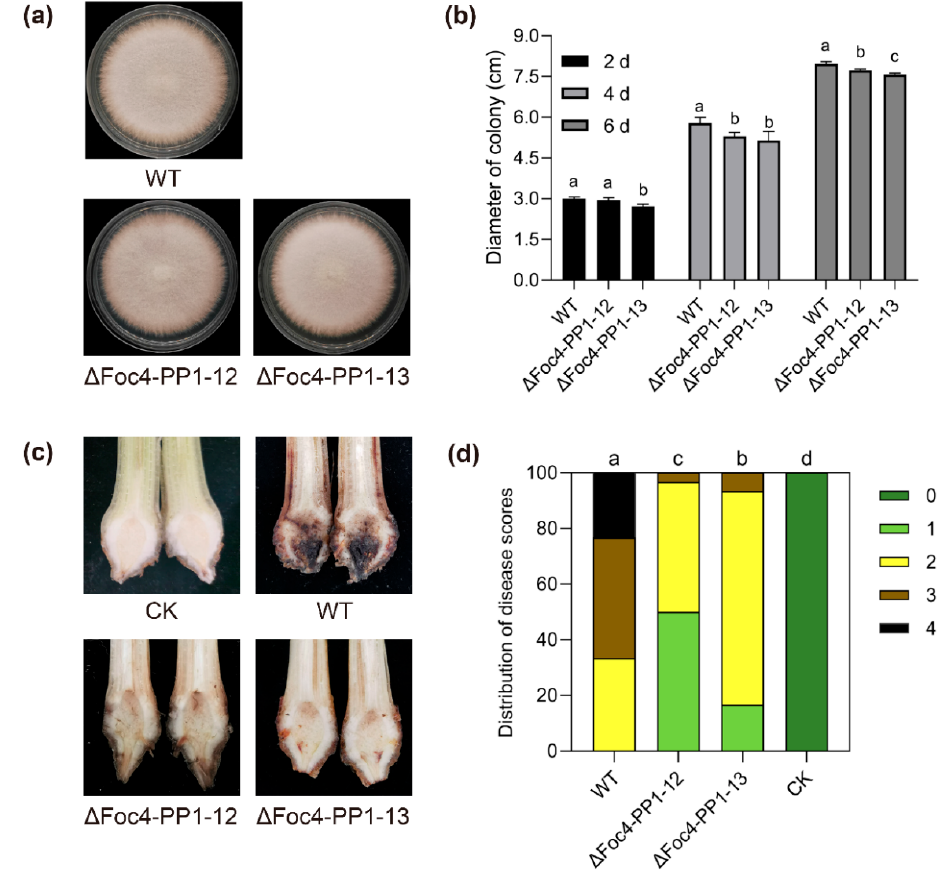
Figure 2. Foc4-PP1 contributes to the virulence of Foc TR4. ( a ) The colony morphologies of WT, ∆ Foc4-PP1-12, and ∆ Foc4-PP1-13 strains after growth on potato dextrose agar (PDA) plates for 6 d. ( b ) Colony diameters after growth for 2, 4, and 6 days. ( c ) Disease phenotype and ( d ) disease index distribution in banana plantlets inoculated with the WT, ∆ Foc4-PP1-12, and ∆ Foc4-PP1-13 strains at 28 days post inoculation. CK: banana plantlets inoculated with water; 0–4: different range of disease scores. Data presented in ( b , d ) are means ± SDs from three independent experiments. The values were analyzed with Duncan’s multiple range tests by SPSS. Columns with different letters indicate a significant difference ( p <